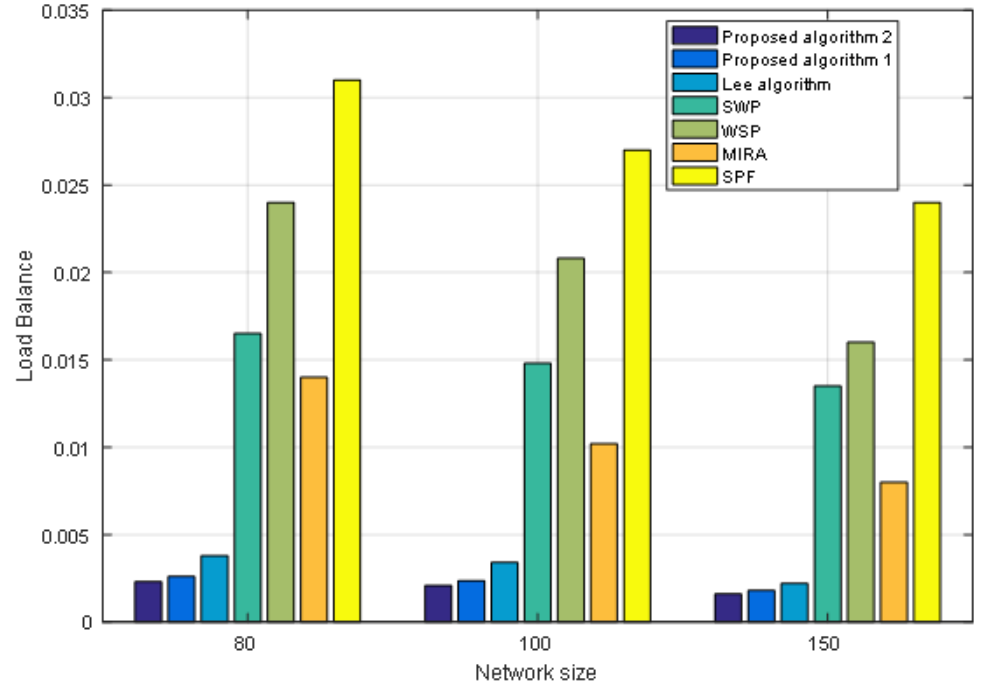
Figure 8. The load balance of network under different network sizes.